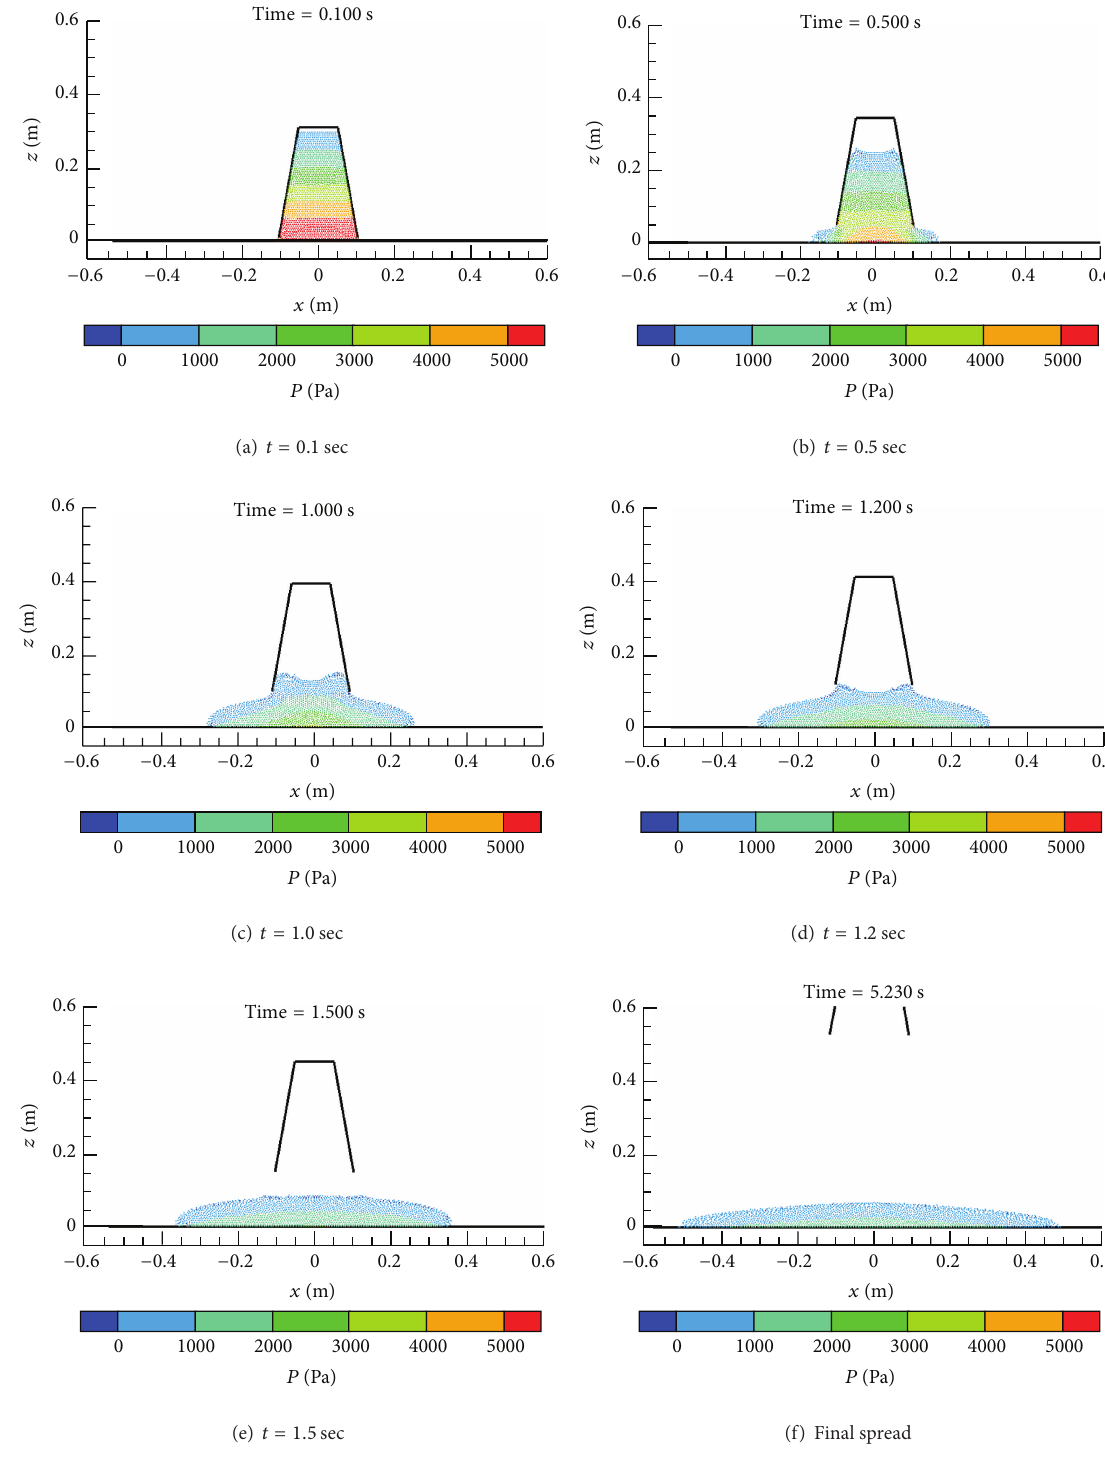
Figure 3: The pressure distribution during slump